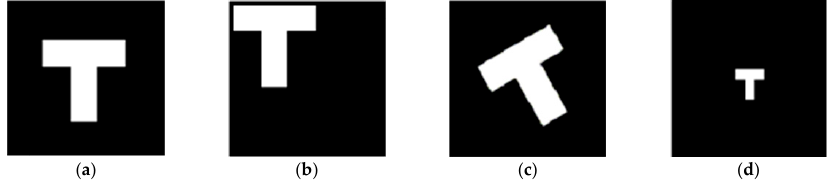
Figure 3. The same image shown with changes in translation, rotation and scale variation: ( a ) original image; ( b ) translation; ( c ) rotation; and ( d ) scaling.